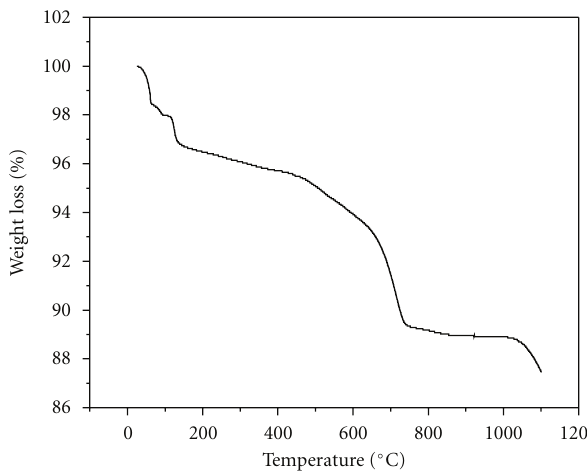
Figure 1: TG analysis of the soil